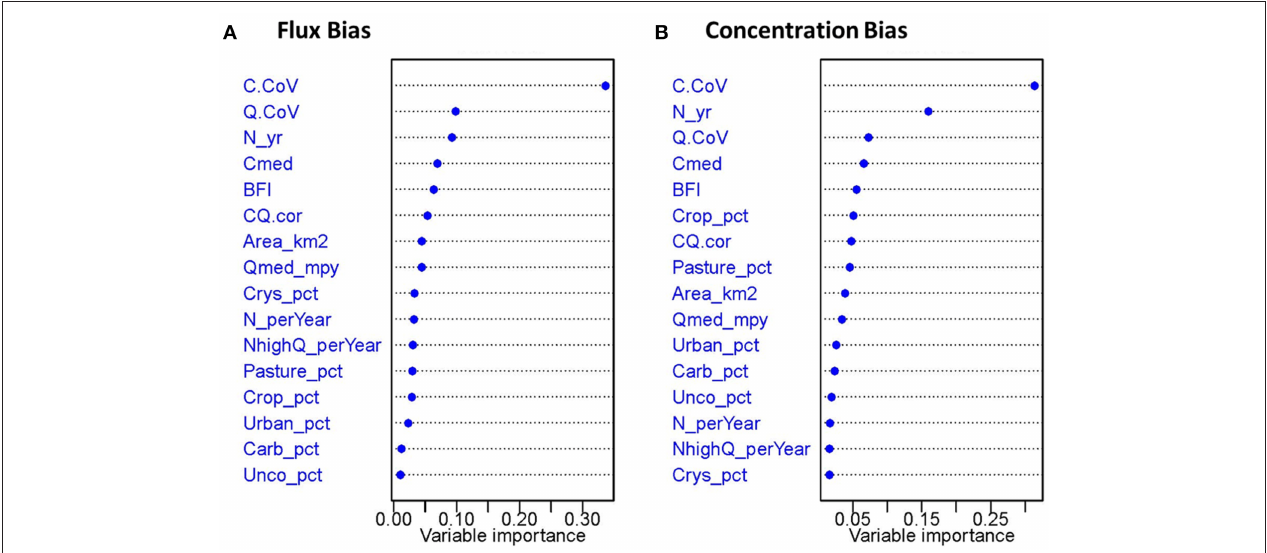
FIGURE 4 | Variable importance ranking from the highest to the lowest based on the three model types developed for constituent (A) flux bias and (B) concentration bias for all site-constituent combinations. See Table 2 for numeric rankings used to calculate variable importance, as described in section Statistical Modeling.